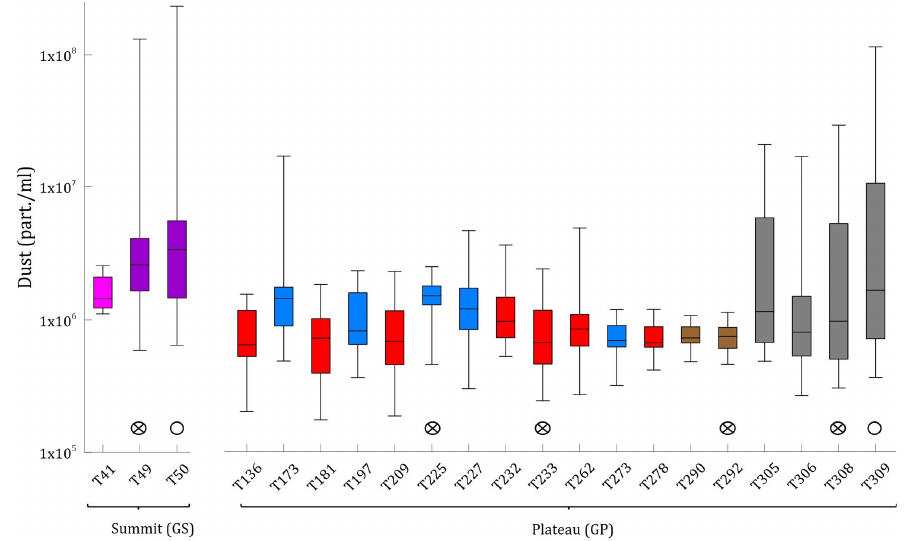
Figure 3. Dust concentration (number of particles/mL) measured by Coulter counter in 1 m ice sections from the GS and GP cores. For each section, the box represents concentrations falling within the 25–75 percentile range. The horizontal bar in the box is the median dust concentration, and the full data range is represented by the whiskers. The dust concentrations of 18 O-enriched or “warm period” ice samples are shown in purple (GS) and red (GP). The dust concentrations of 18 O-depleted or “cold period” ice samples are shown in pink (GS) and blue (GP). Dust concentration data for the deepest GP ice samples are shown in brown and grey, referring to the dust’s dominant color, independent of the sample’s mean δ 18 O value. The circles mark in which 1 m section a dust filter was sampled and analyzed for elemental and isotopic geochemistry (crossed circles) or mineralogy (open circles).